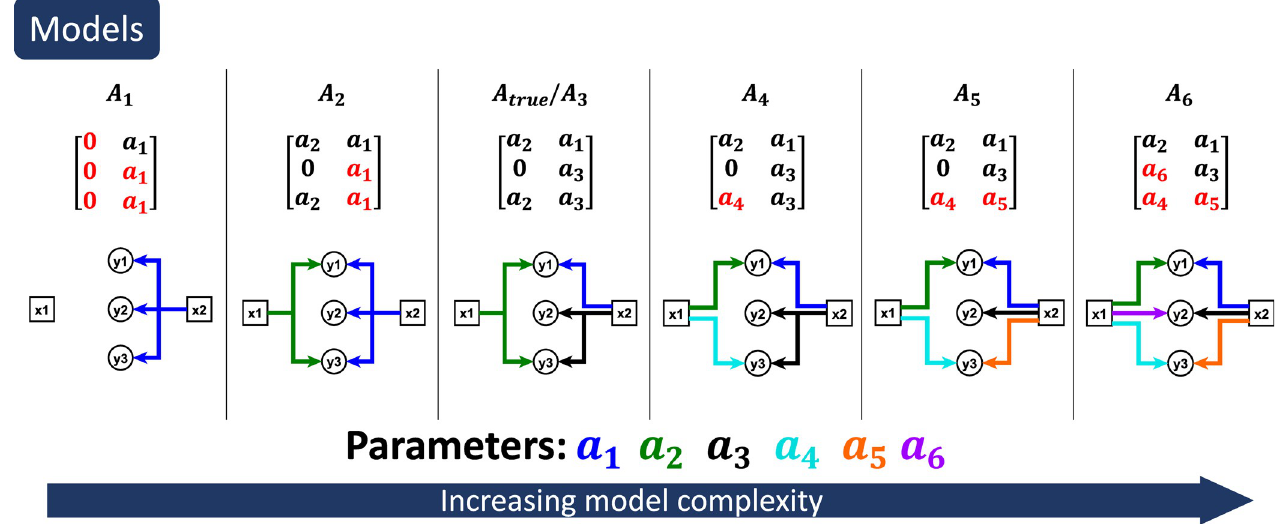
Fig 5. Six different model structures for the linear model. This example is chosen as a simple representation of a mass flow model. The top row shows the model names A 1 , ... ,A 6 . The second row shows the matrices that constitute the model structures. The third row constitute visual illustrations of how the corresponding matrices connect the inputs x i and the outputs y i via the parameters a 1 , ... ,a 6 .